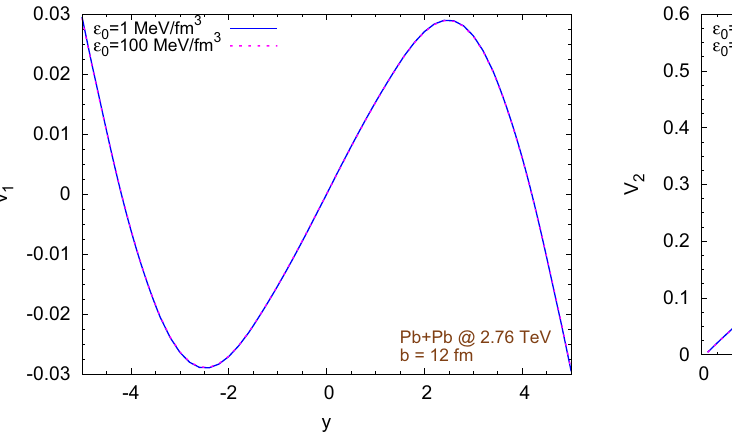
magnetic fields. Left figure: integrated directed flow of charged pions vs rapidity. Right figure: elliptic flow of charged pions at mid-rapidity vs transverse